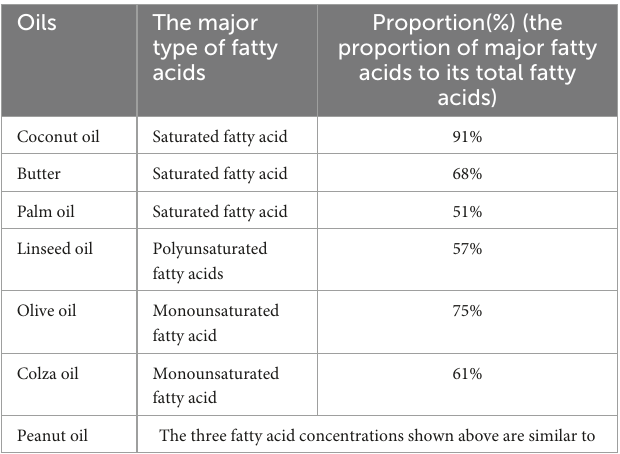
TABLE 2 A list of the primary ingredients of several oils available